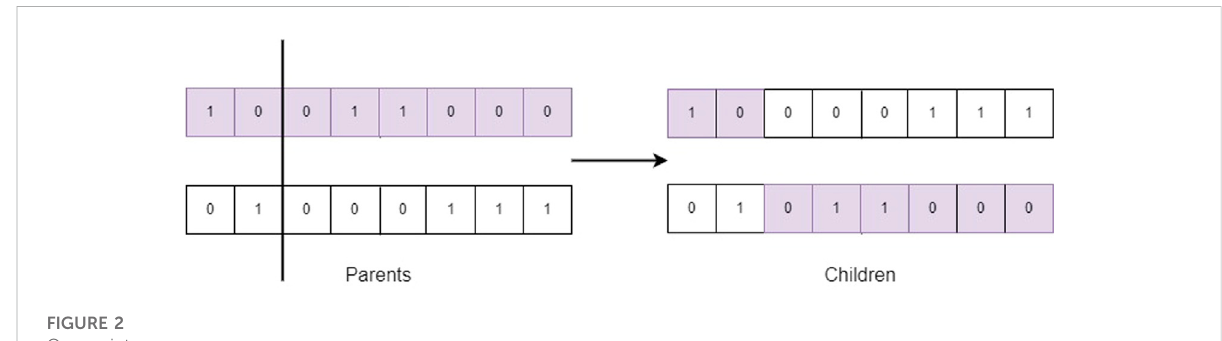
FIGURE 2 One-point